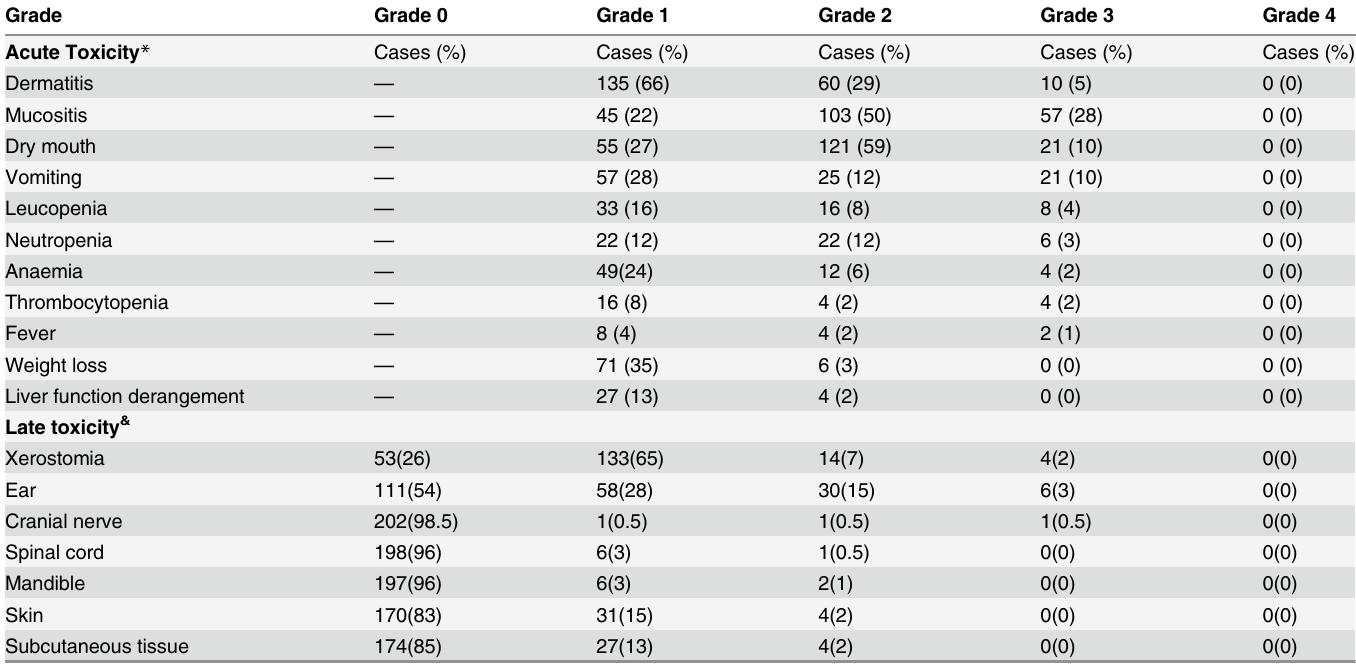
respectively. Six (3%) patients developed RTOG grade 3 hearing loss, and seven (3.5%) had MRI-diagnosed temporal lobe necrosis (TLN). All these patients with TLN had stage T3 – 4 dis- ease, with wide skull base erosion or intracranial invasion (Table 6). Table 6. Frequency of worst acute toxicity and late toxicity in 205 nasopharyngeal carcinoma patients treated with volume-modulated arc therapy.